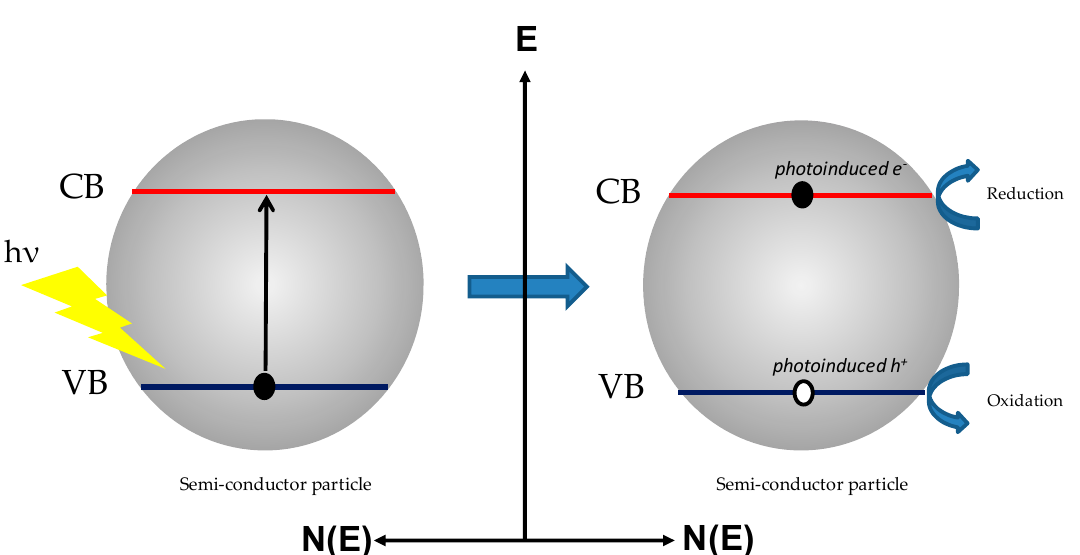
Figure 2. Light-induced charge separation process in a semi-conducting